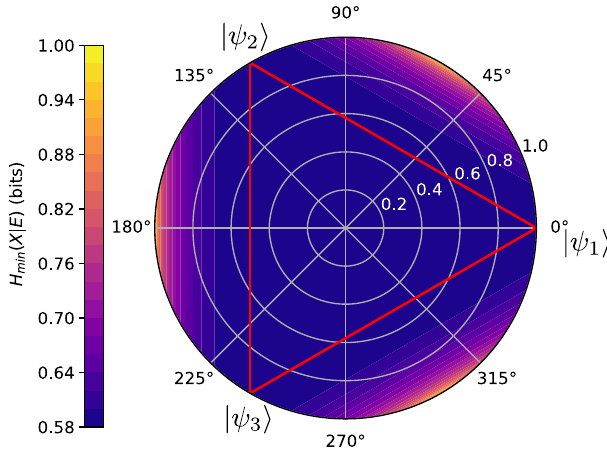
Fig. 1 Min-entropy contour plot. Contour plot of H min ( X ∣ E ) for the three-outcome POVM ^ F 3 k in function of the projection of ^ ρ A in the ZX plane (cid:4) (cid:5) (cid:4) of the Bloch sphere. The states Ψ i are associated to the POVM elements. For experimental probabilities inside the red triangle 0.58 bits of randomness can be certi fi ed, while for the region outside the triangle up to 1bit can be certi fi